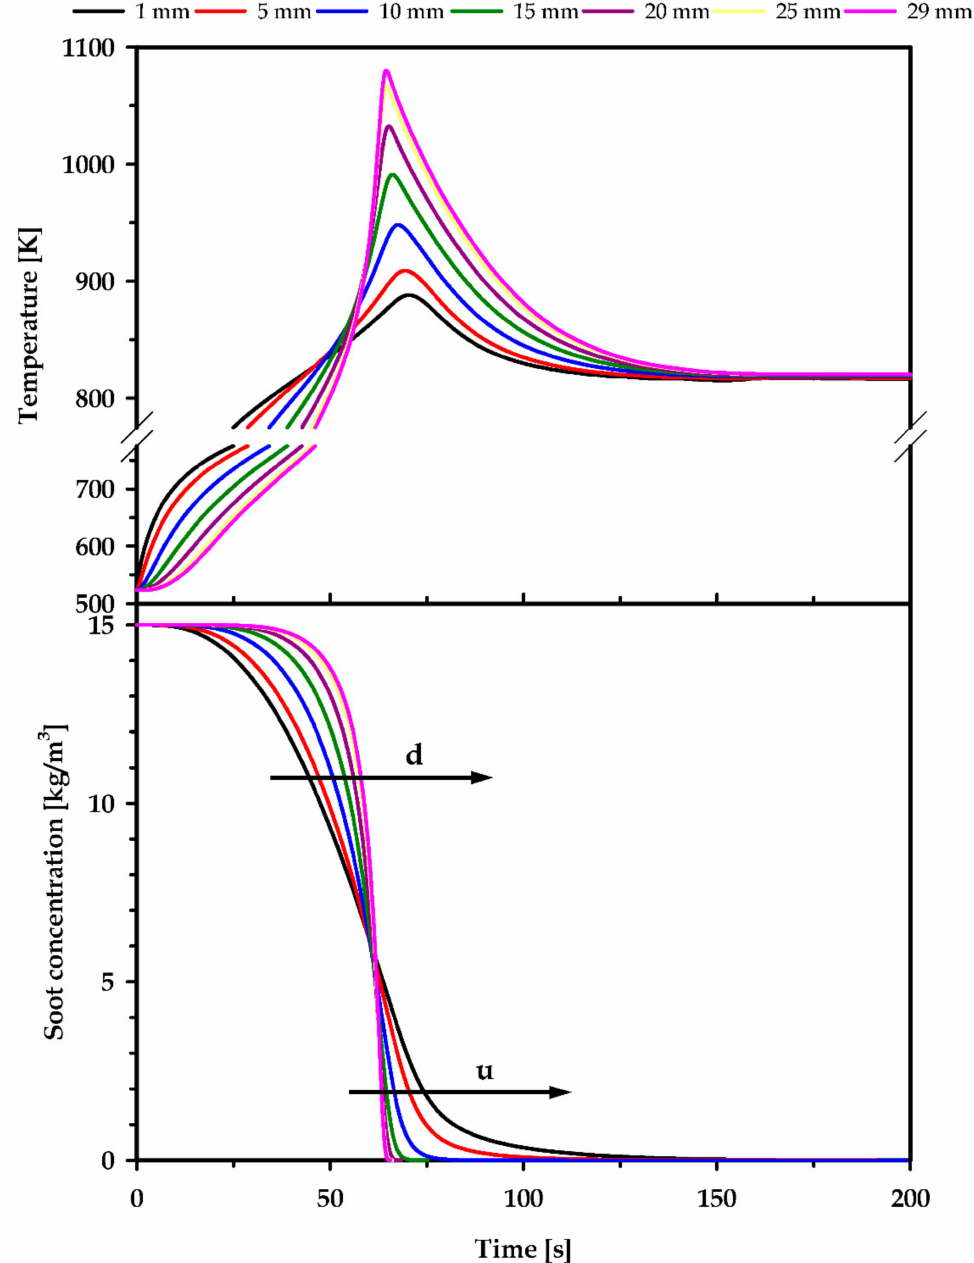
Figure 4. Time histories of temperature and soot concentration (monitor points of Figure 2): k = 5. Thearrowsindicatethedirectionofpropagationofthereactionfront: d = downstreampropagation(from upstream—1 mm-to downstream—29 mm); u = upstream propagation (from downstream—29 mm-to upstream—1